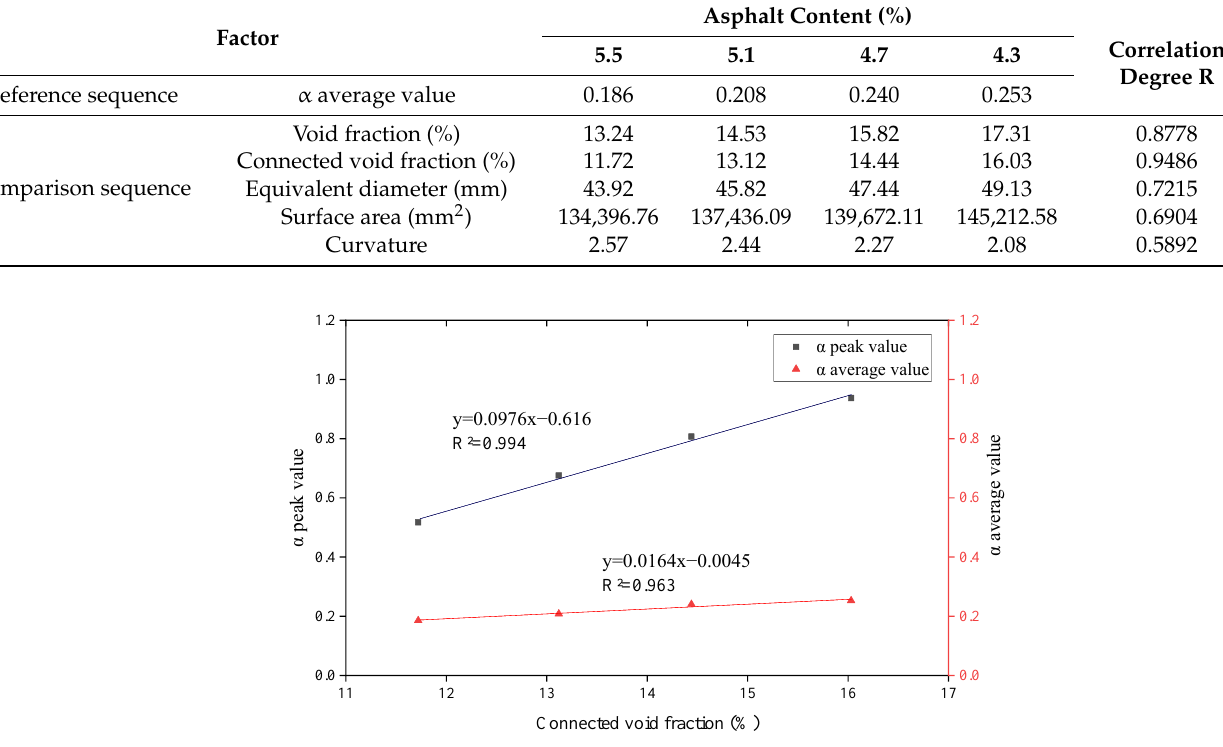
Table 14. Gray correlation analysis of the average sound absorption coefficient and void characteristic parameters.